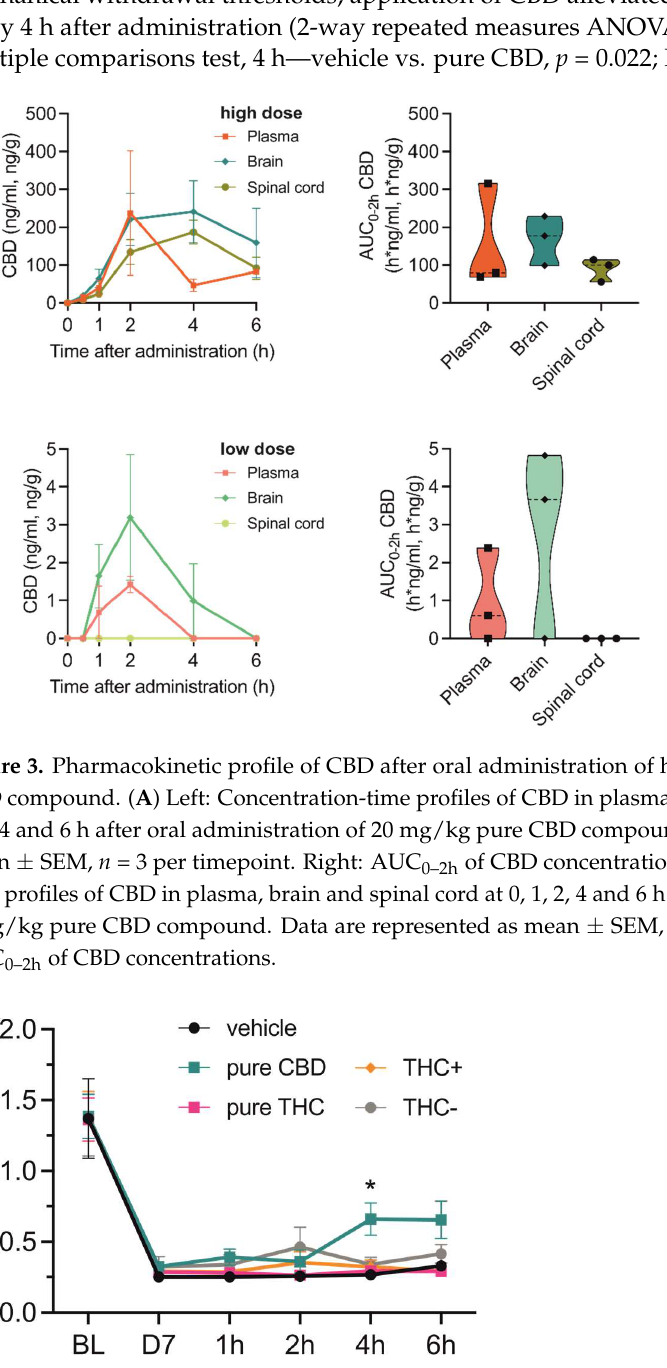
Figure 4. Effect of single-dose oral administration of cannabis extracts and pure cannabinoid com- pounds on mechanical thresholds in neuropathic mice. Mechanical paw-withdrawal thresholds of neuropathic pain mice were determined using von Frey filaments at baseline (BL), on day 7 after surgery (D7), as well as 1, 2, 4 and 6 h after single-dose oral administration of vehicle (i.e., sesame oil), 20 mg/kg pure CBD and THC compounds, 40 mg/kg THC+ extract and 1560 mg/kg THC- extract. Data are represented as mean ± SEM, n = 10 per treatment group. * p < 0.05, 2-way ANOVA followed by Dunnett’s post hoc test.